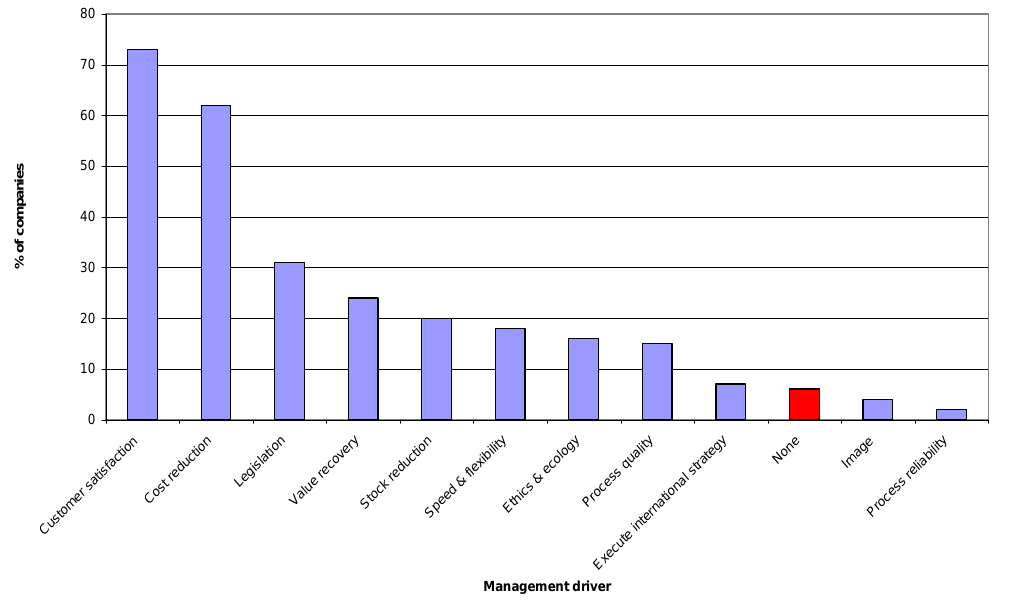
Figure 3. Management drivers for reverse logistics for returns of commercial products When asked on the drivers to deal with packaging returns, then cost reduction became the first driver when compared with customer satisfaction. As customer involvement is lower for packing and support materials, cost reduction is the primary focus. Less than 25% of respondents focus on value recovery, although the value of durable packaging and returnable transport items such as the ‘europallets’ (approximately 7 €/piece) should not be